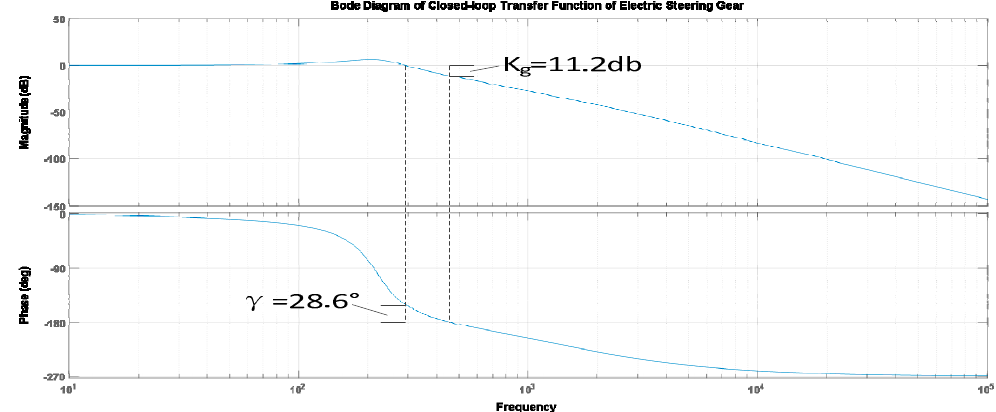
Figure 3. Bode diagram of the closed-loop transfer function of the steering gear.